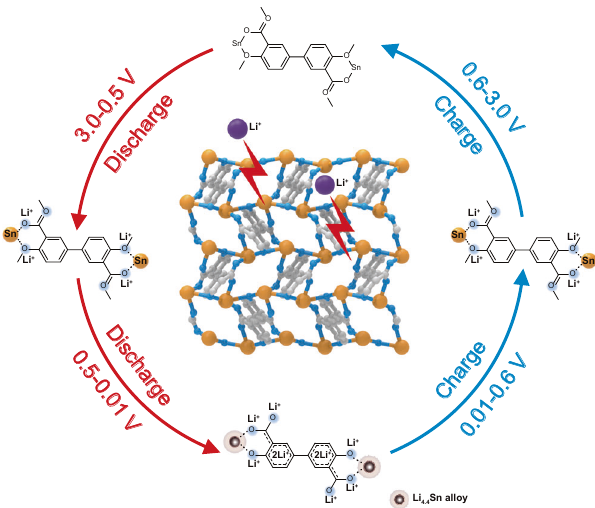
Fig. 6 Reaction mechanism of Sn-MOF. Schematic gradual lithiation and delithiation of metal centers and organic ligands of amorphous Sn 2 (dobpdc) during discharge – charge